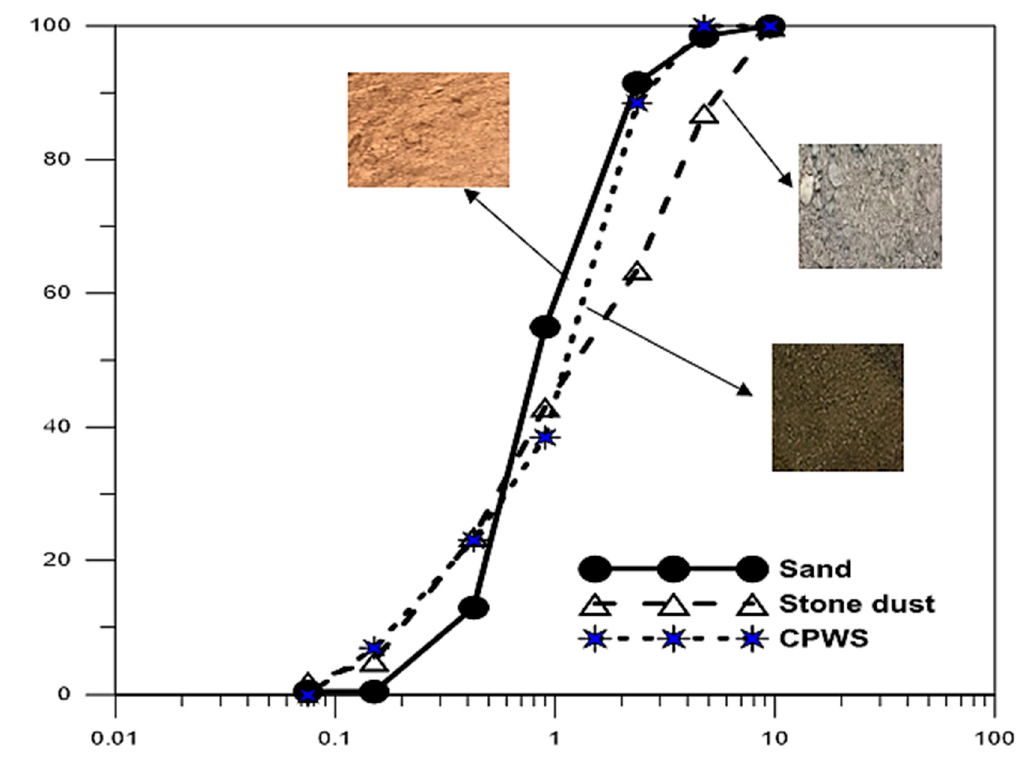
Table 3. Particle size distribution of aggregate.